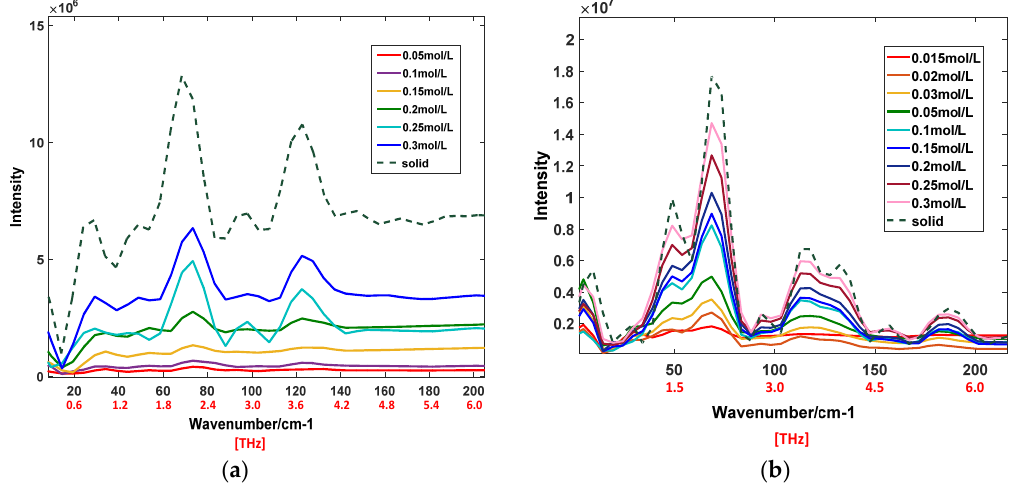
Figure 9. ( a ) THz Raman spectra of uracil aqueous solution at different concentrations. ( b ) THz Raman spectra of 2-hydroxy BA aqueous solution at different concentrations.